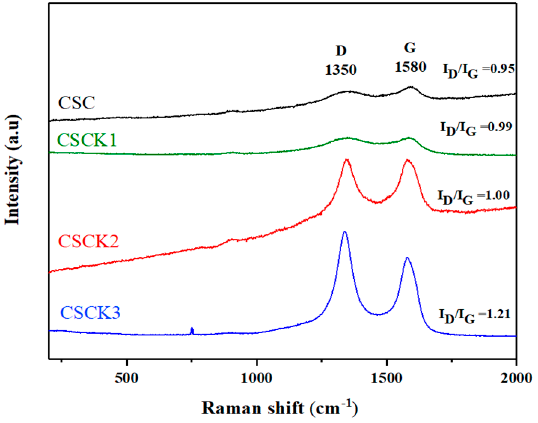
Figure 3. Raman spectra for the as-prepared CSC and